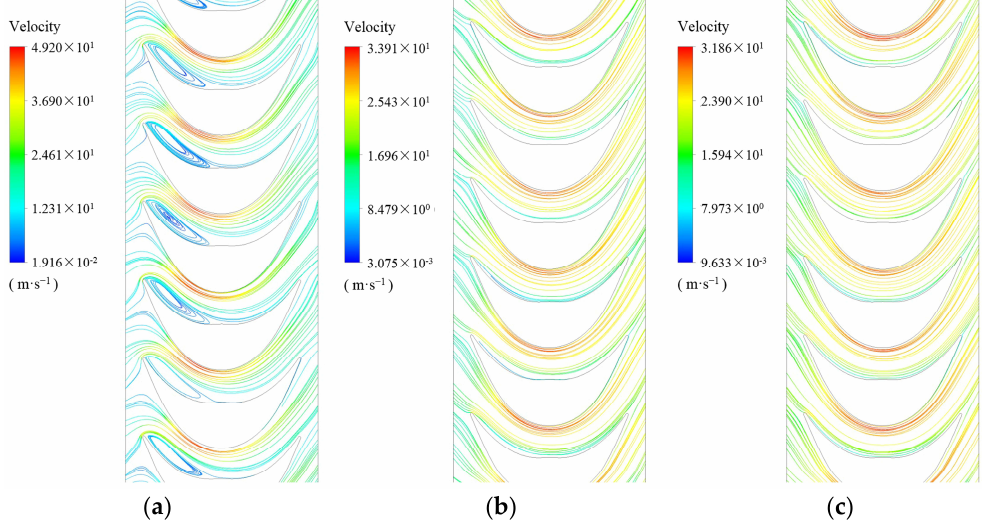
Figure 6. Flow pattern for different flow coefficients φ . ( a ) φ = 0.38; ( b ) φ = 1.33; ( c ) φ =